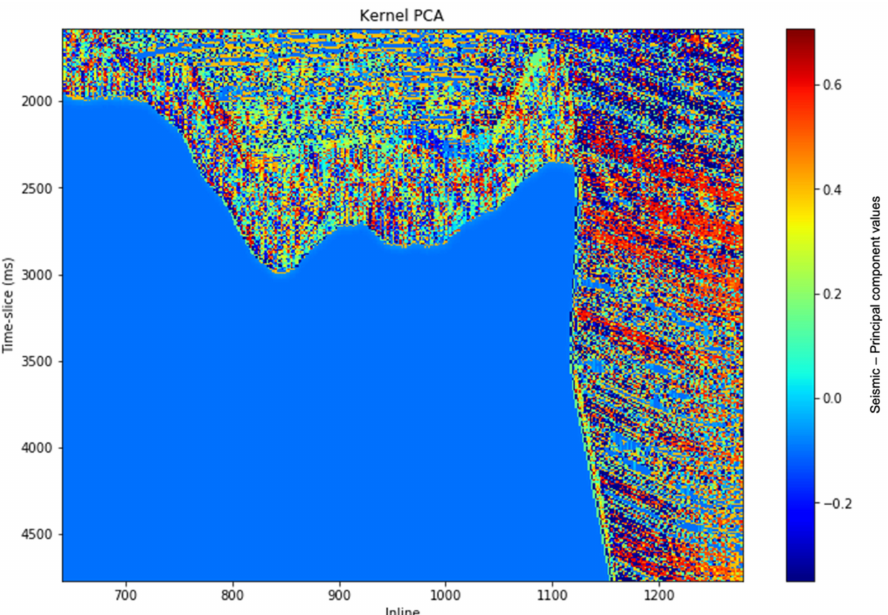
Figure 10. The KernelPCA result of reducing the multi-attributes for salt delineation analysis.